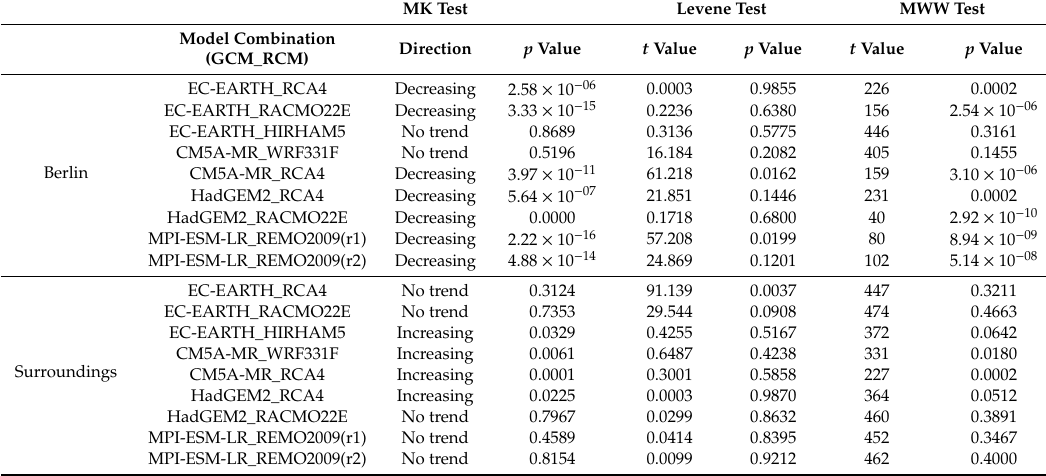
Table A2. Outcomes of the Mann-Kendall (MK) test, Levene test, and Mann-Whitney-Wilcoxon (MWW) test for relative humidity for Berlin and its